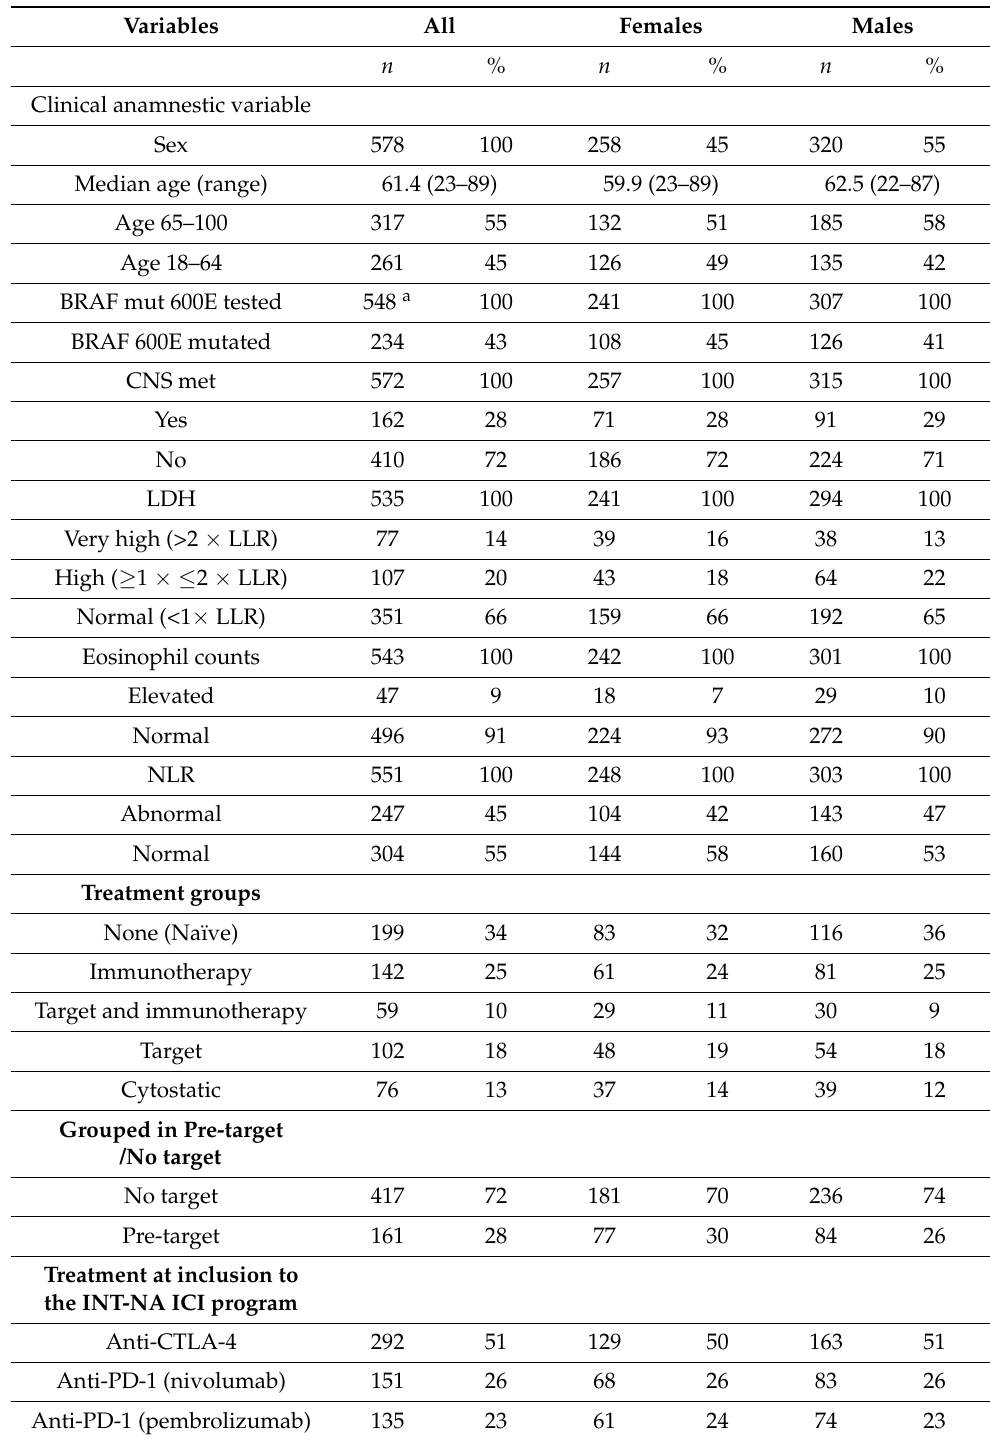
Table 1. Clinical–pathological characteristics of cutaneous melanoma patients. Description of the patient population and inclusion criteria adapted to the real-life